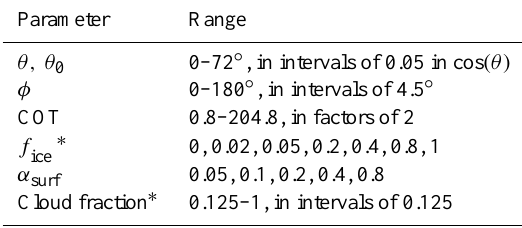
Table 2. Parameter space explored in the CPP test in Sect.